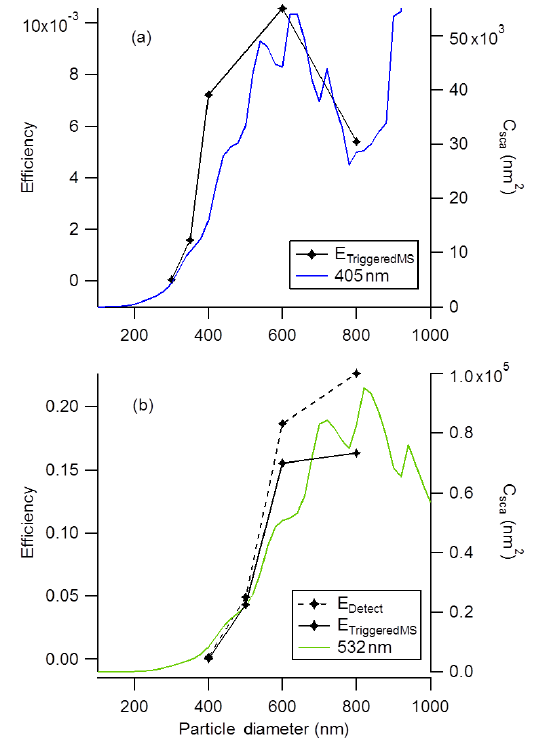
Figure 6. Instrument performance measurements in “second-laser- only” acquisition mode ( E d ). Measurements are the com- TriggeredMS parison of number concentration obtained by the CPC with the num- ber of mass spectra (cm − 3 ) obtained by the LAAP-TOF when sam- pling size-selected laboratory-generated PSL aerosol. The scatter- ing cross section ( C sca ) for the respective wavelength is plotted for reference. (a) Detection system A with the C sca profile for 405nm light. (b) Detection system B with the C sca profile for 532nm light. The detection efficiency E Detect of detection stage 2 is also plotted in panel (b) , which represents the number of trigger events gener- ated by the optical detection